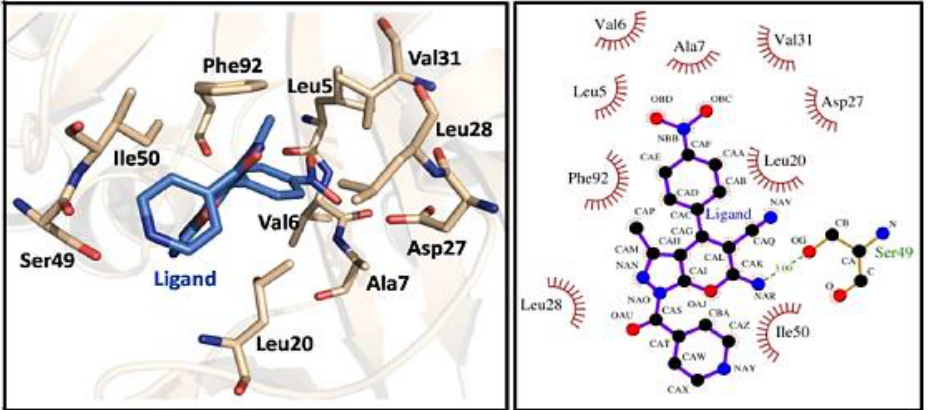
Figure 2. Molecular docking of compound 7 (R = 4-NO 2 C 6 H 4 ) with Staphylococcus aureus wild-type DHFR (PDB ID: 2w9g). The left panel shows the zoomed-in view of the ligand interactions with the DHFR active site amino acid residues in the 3D space. The right panel shows the 2D representation of the array of ligand−protein interactions. Hydrogen bond formation is indicated by the green dotted line, whereas hydrophobic interactions are indicated by the spiked arcs. Image adapted from Mali et al. [26].